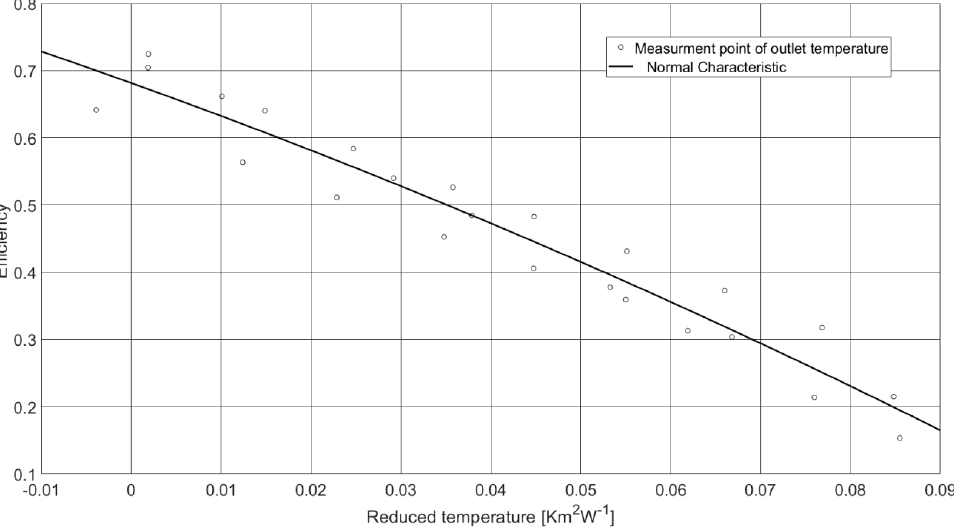
Figure 12. Solar irradiance and working medium temperature values in the system during the experiment.